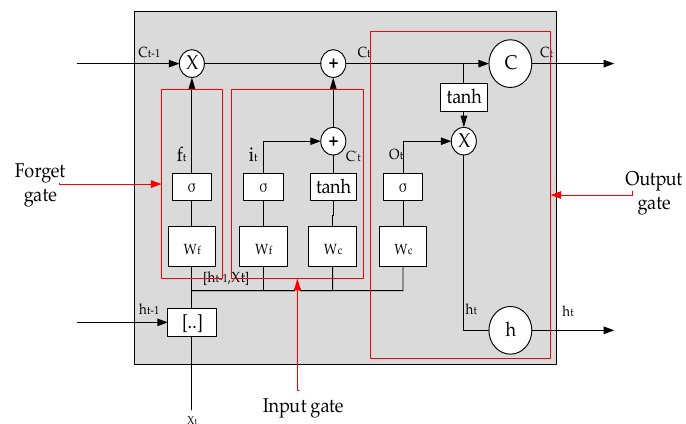
Figure 2. Long short-term memory (LSTM) structural unit diagram.